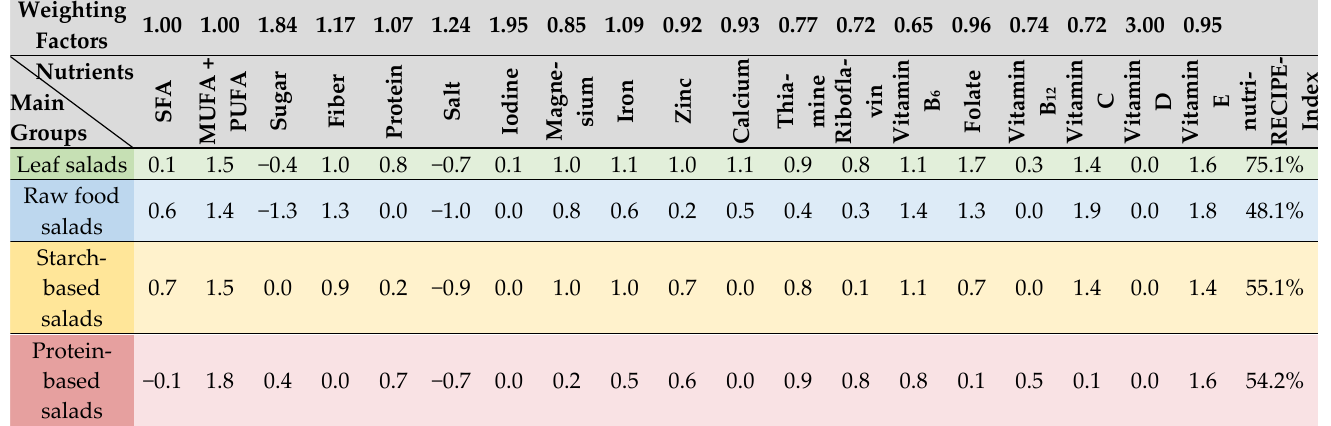
Figure 2. Comparison of the median Big7 values of the main groups. Plot of all Big7 medians in kJ/g per 100 g for each main group. Shows the significant differences in energy [kJ per 100 g] and total fat, SFA, total carbohydrates, sugar, protein, and salt content [g per 100 g] between the main groups according to Kruskal-Wallis test plus pairwise comparisons with Bonferroni correction. Error bar shows 95%-CI; *: p < 0.05; **: p < 0.01; n, number of salads; SFA, saturated fatty acids. Table 3. Comparison of the median nutriRECIPE-Index-scores and total nutriRECIPE-Index values of the main groups.